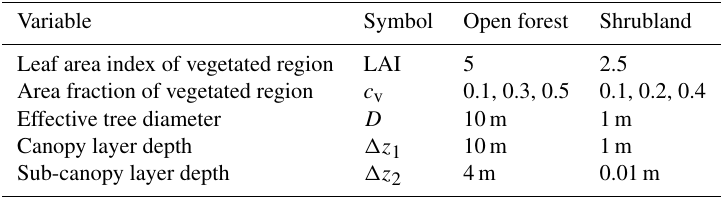
Table 1. Variables describing the geometry of “Open forest” and “Shrubland” RAMI4PILPS scenarios simulated in this paper (see Wid- lowski et al., 2011). The leaf area index of a vegetated region is defined as the total leaf surface area divided by the downward projected area of the